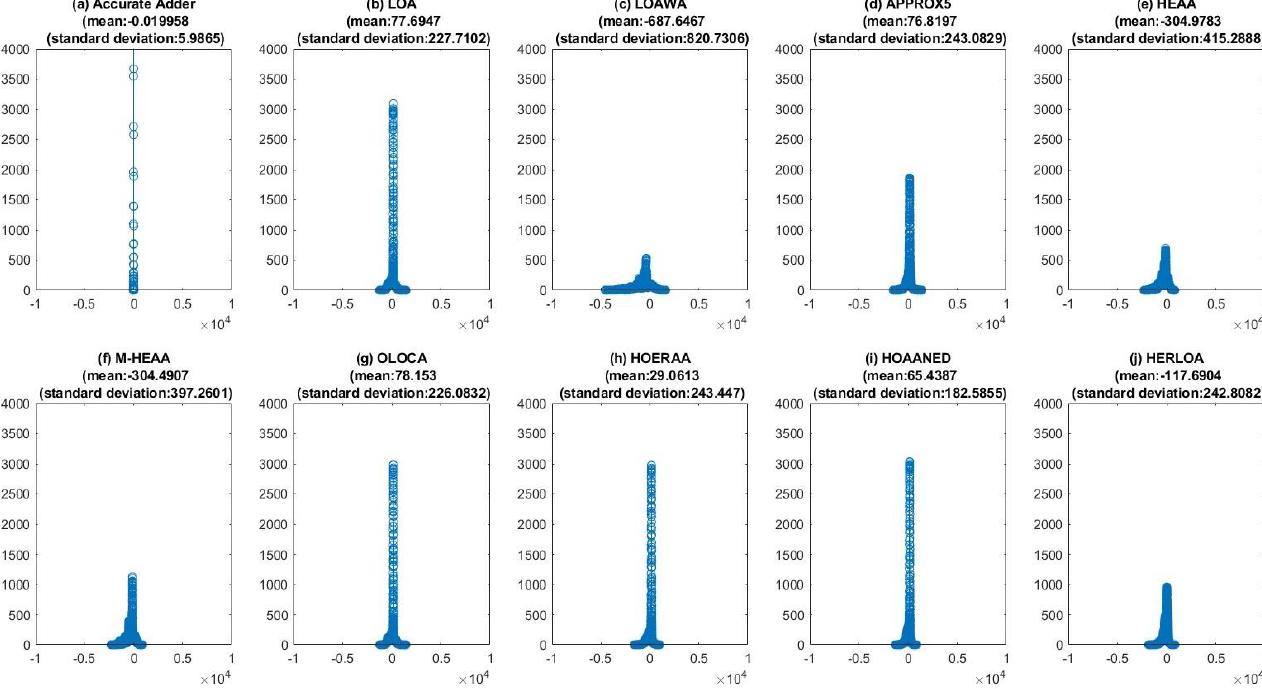
Figure 13. Plots showing the DPV between the Black Hole image compressed using accurate and approximate adders and the original Black Hole image, with the approximate adders having an 11-bit inexact part.